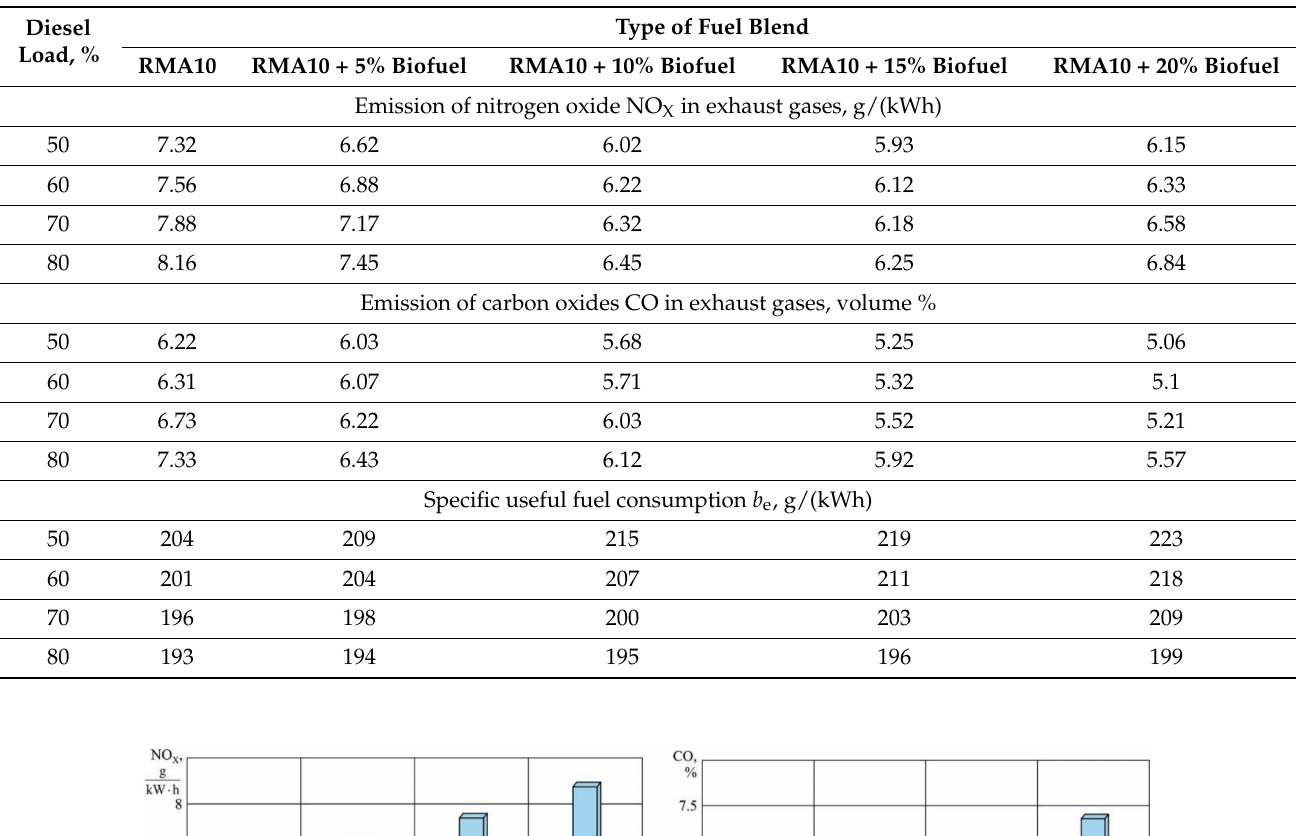
Table 3. Results of the experiment.